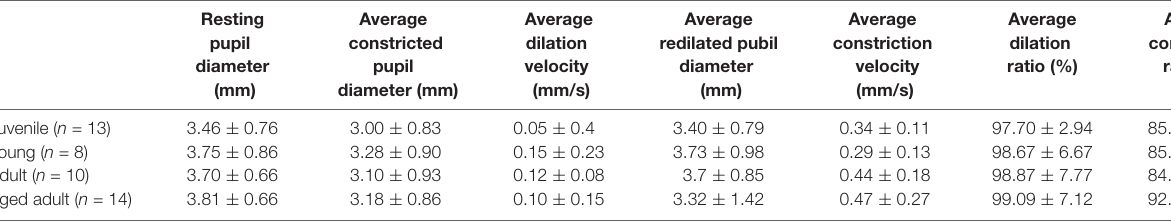
TABLE 5 | Pupillary light reflex (PLR) parameters analyzed in degus.